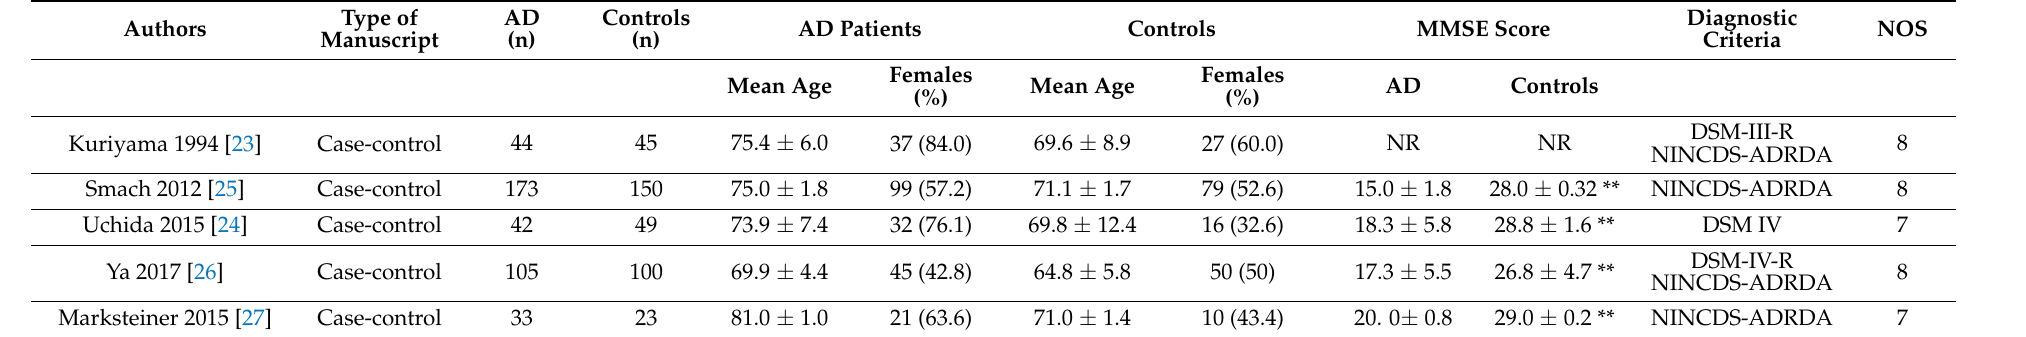
Table 1. General characteristics of the population enrolled.